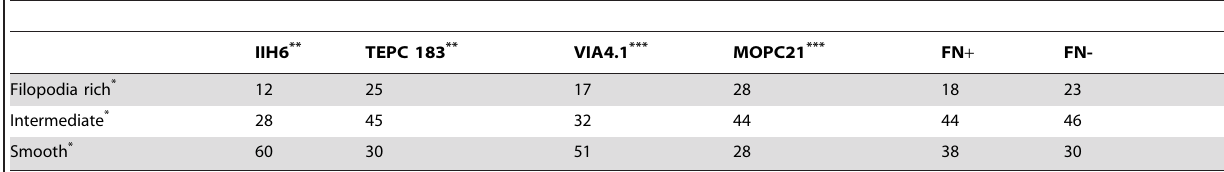
Table 1. Percentages of podocytes with smooth, intermediate or filopodia rich surfaces after in vitro ligation with a -dystroglycan specific antibodies, fibronectin and their respective